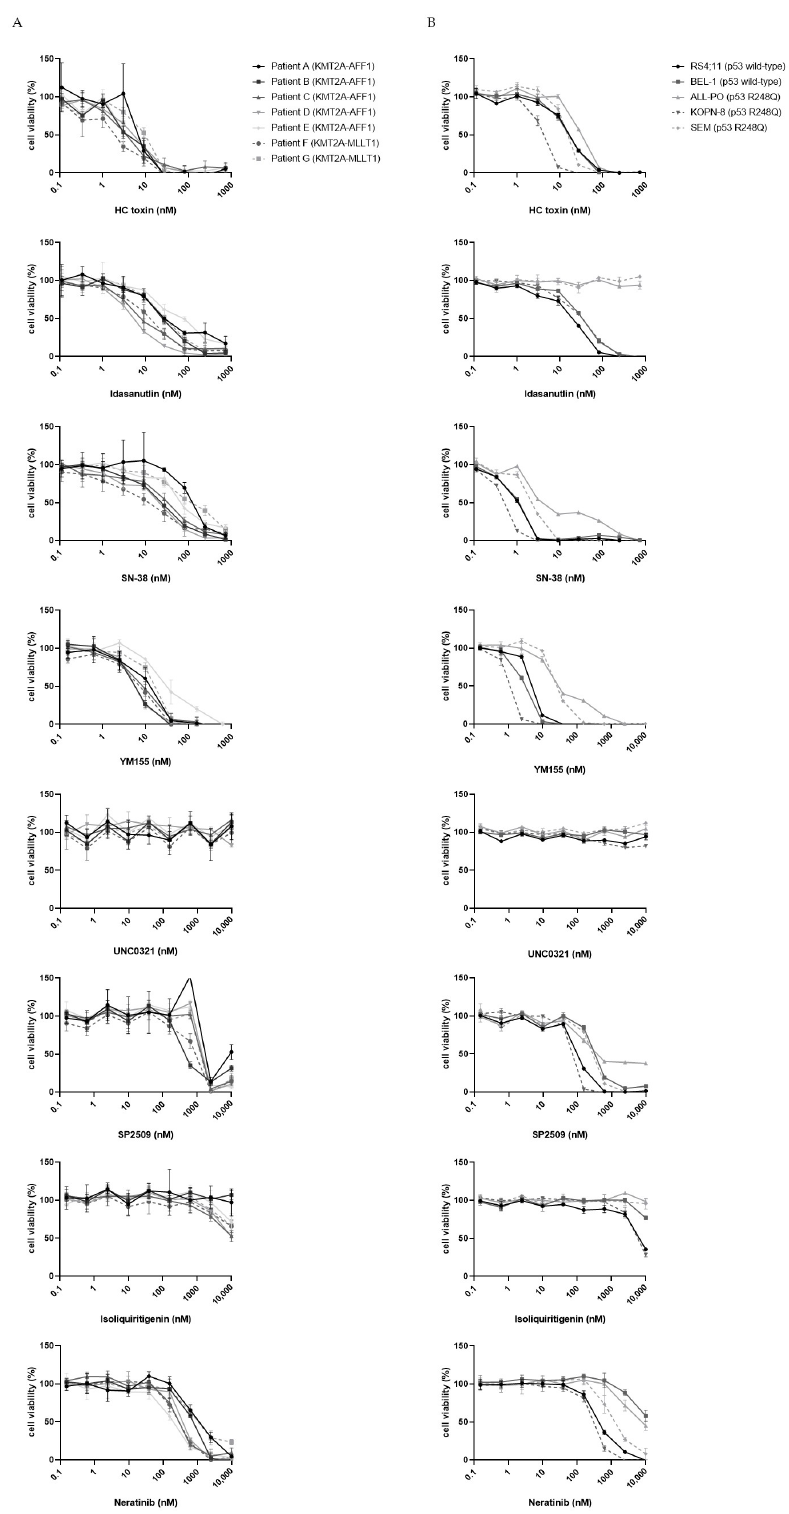
Figure 2. Validation of candidate drugs on patient-derived KMT2A -rearranged infant ALL cells and KMT2A -rearranged ALL cell lines: broad-range dose–response curves of eight candidate drugs on ( A ) primary KMT2A -rearranged infant ALL patient samples ( n = 7) and ( B ) various KMT2A -rearranged ALL cell line models ( n = 5). Cell viability is based on a 4-day MTT assay and normalized to DMSO controls. Data points are represented as the mean ± SD of n = 3 technical